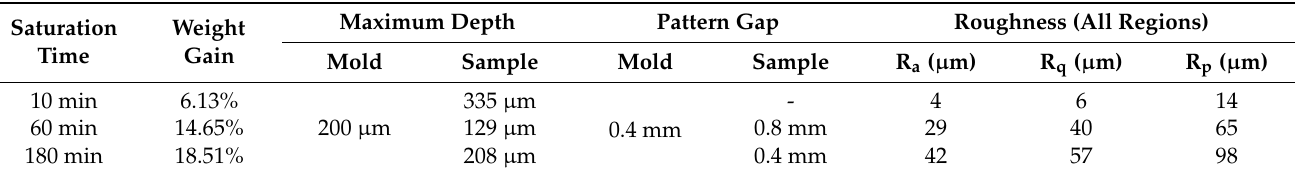
Table 5. Summary of experiment results of